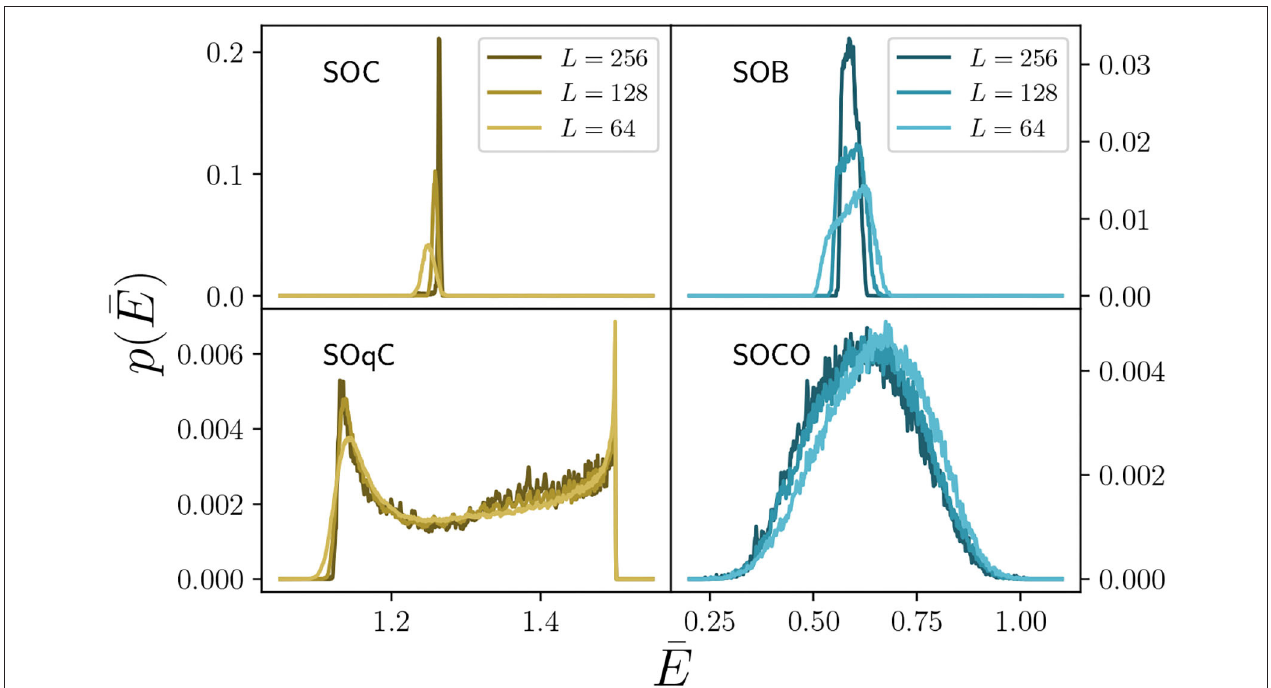
FIGURE 3 | Distribution of average energy density E at the stationary state in the different types of self-organization mechanisms for finite system sizes. In the case of SOC and SOB (upper panels), the (unimodal) distribution of energy values becomes progressively more peaked at the transition point as the system size is enlarged, converging as N to perfect self-organization to the transition point (either a critical point E c for SOC, or the Maxwell point E M for SOB). In the absence of a → ∞ conservation law, i.e., in the presence of non-vanishing dissipation term (bottom panels), the distribution remains broad even in the N presence of excursions of E to both sides of the transition: both in SOqC and in SOCO, the system continuously shifts between the active and absorbing regimes, even in the limit of infinitely-large system sizes. In the case of SOqC, the distribution is broad and bimodal. In the case of SOCO, the broad distribution results from the presence of ongoing oscillations from one phase to the other. In all cases, we simulated the corresponding Langevin equations as described in the text [e.g.,